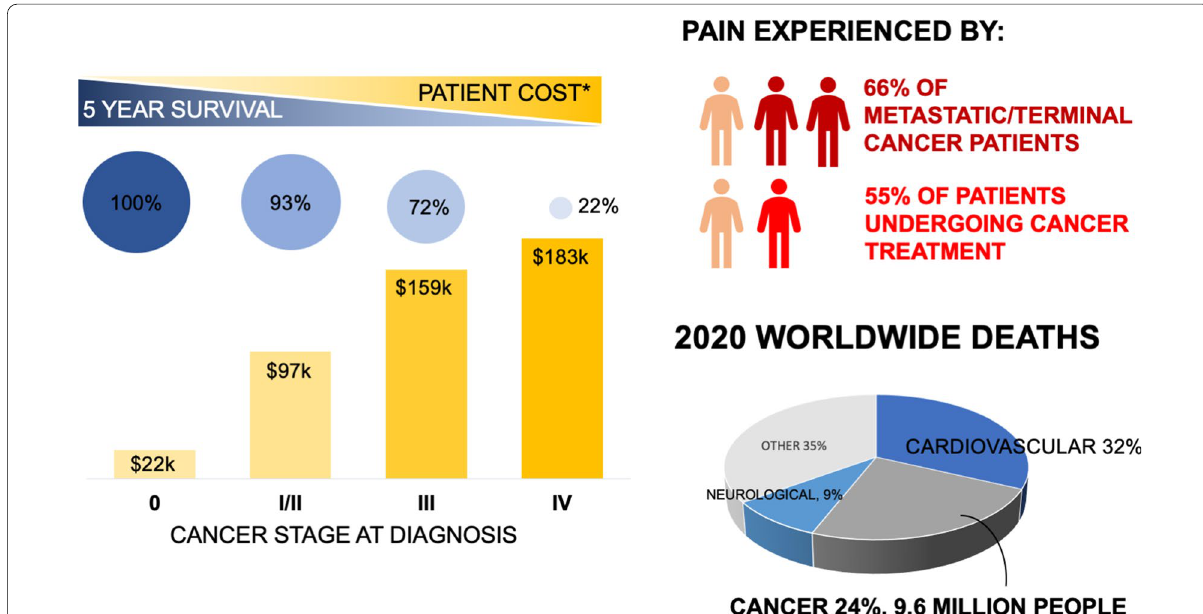
Fig. 1 Late stage diagnoses for cancer results in significantly higher patient costs and decreased 5-year survival rates. The burden of cancer severely impacts patient quality of life with a majority experiencing pain directly from the disease and/or from treatment side effects. As the second leading cause of deaths worldwide, it is pertinent that new avenues are explored to improve cancer therapies and diagnostics